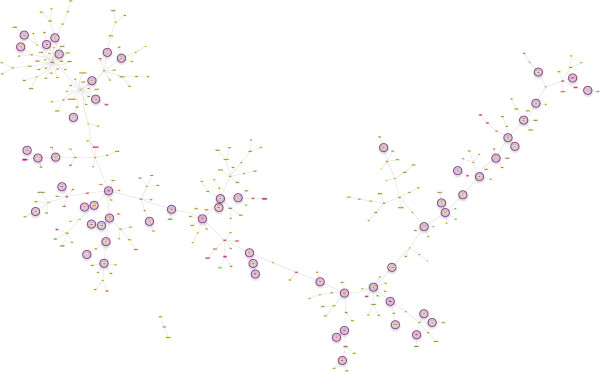
Predicted co-citation network from Cardoen et al.[11]gene list for 18-day-old workers. Description of symbols and topography is as for Figure 1, with the exception of a colour code change: genes ranging from yellow to green are up-regulated in ovary in-active bees and genes ranging from yellow to purple are down-regulated in ovary active bees.